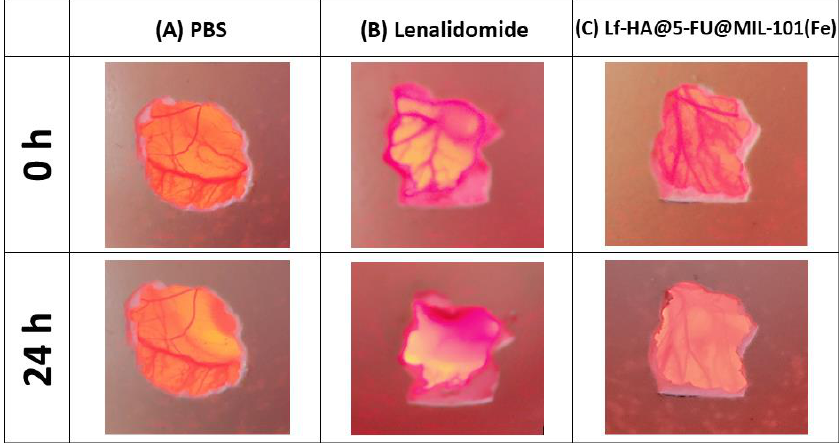
Figure 10. Chorioallantoic membrane (CAM) assay. ( A ) Treatment with PBS. ( B ) Treatment with Lenalidomide. ( C ) Treatment with SM-MIL. Lenalidomide. ( C ) Treatment with